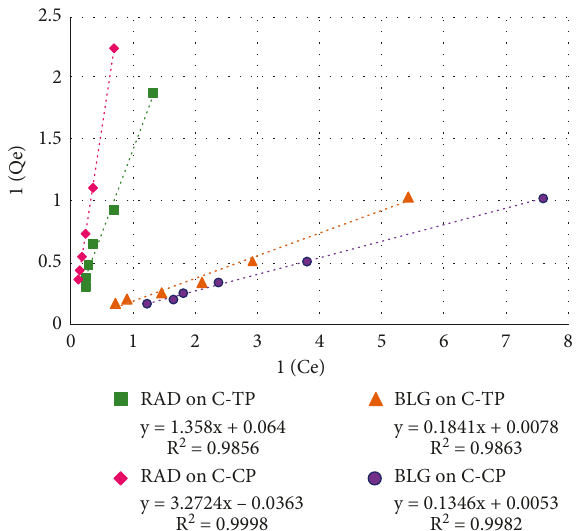
Figure 14: A comparison of the Langmuir isothermal model for the adsorptive dye removal efficiency of acid-treated biosorbents. Initial pH � 5, final pH for RAD on C-TP and C-CP � 4, BLG on C- TP � 4.5, and BLG on C-CP �